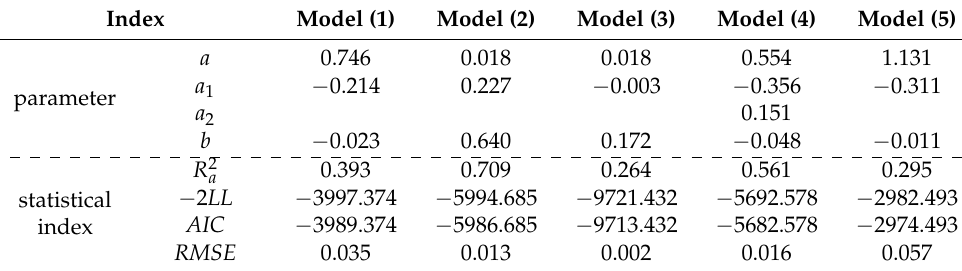
Table 6. Fit Statistics of the Generalized